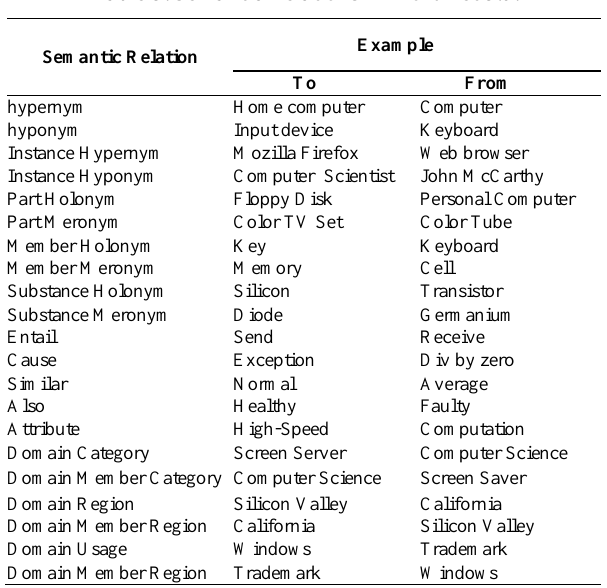
Table 3. Semantic Relations in WordNet 3.0.